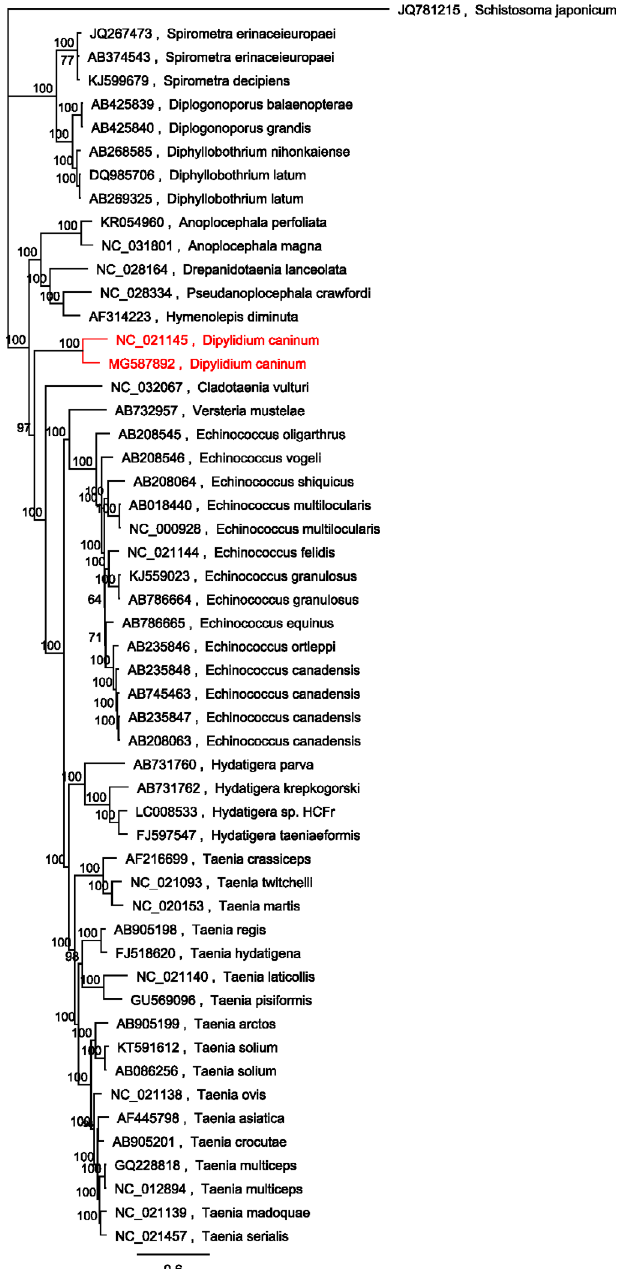
Figure 3. Tree obtained after concatenation of the 12protein- coding genes from D.caninum R166 and after those of 52other tapeworms were subjected to multiple alignment, followed by maximum likelihood and Bayesian inference analysis (average standard deviation of split frequencies was below 0.005), using Schistosoma japonicum as the